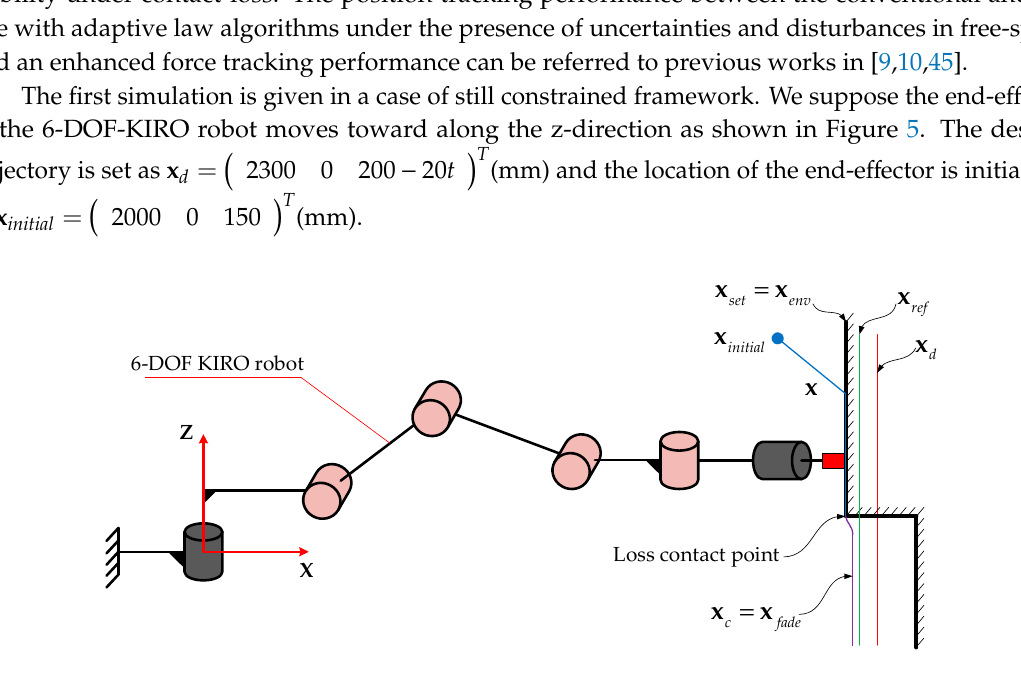
Figure 6. Position response along the X-direction. P o s i t i o n ( mm )